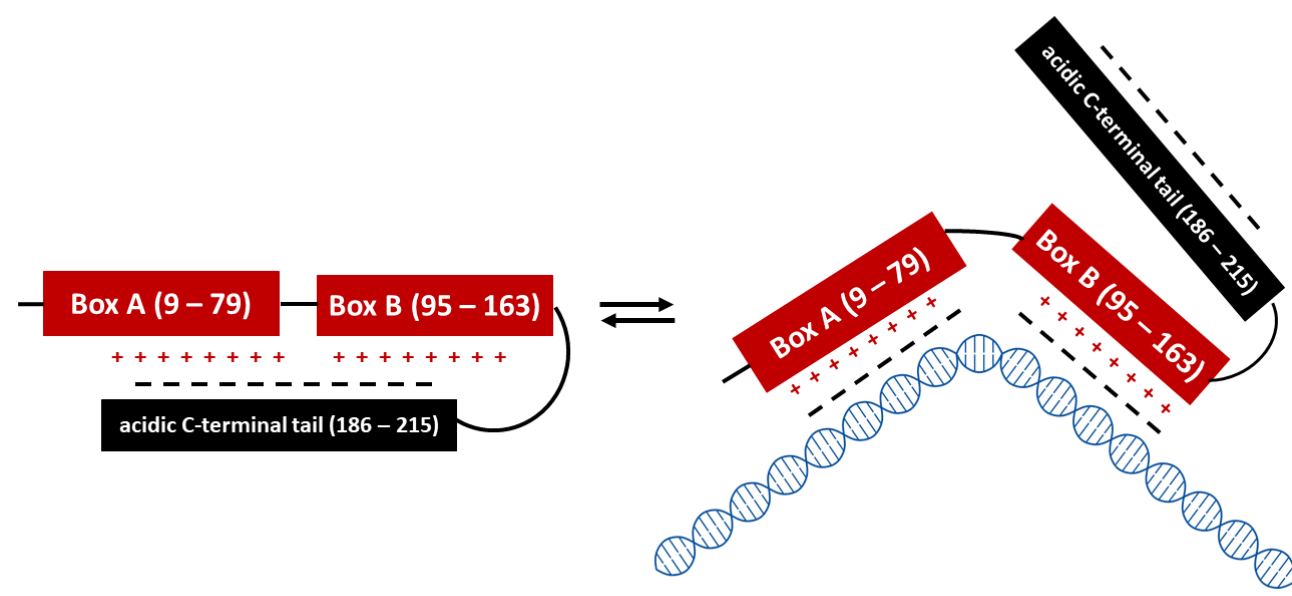
Figure 1. Dynamic equilibrium of unbound and DNA-bound HMGB1 structure. Schematic repre- sentation of human HMGB1. The three domains are represented by colored boxes. Red: positively charged DNA-binding Boxes A and B, black: negatively charged acidic tail. Interactions between positively charged Boxes A and B and the negatively charged acidic tail regulate HMGB1 DNA-binding activities by competitive electrostatic interactions.